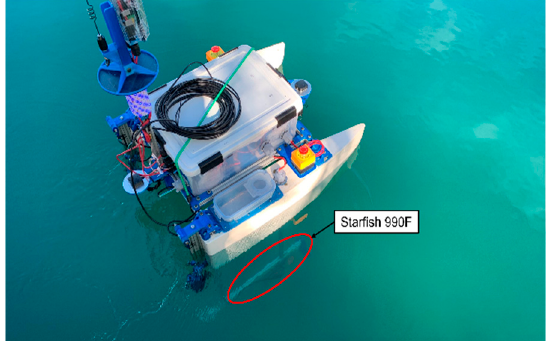
Figure 4. MRSUH equipped with the Starfish 990F under the vessel.